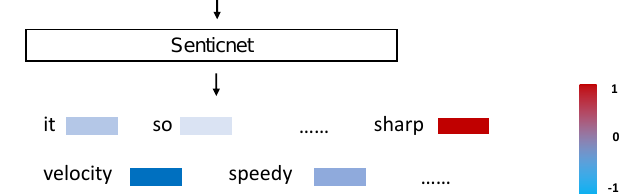
Figure 1. Attention weights towards aspects. Words in black bold are aspects; words with a blue background are predicted attention weights; words with a green background represent desirable attention distribution. A word in the darker color indicates a greater weight and vice versa.